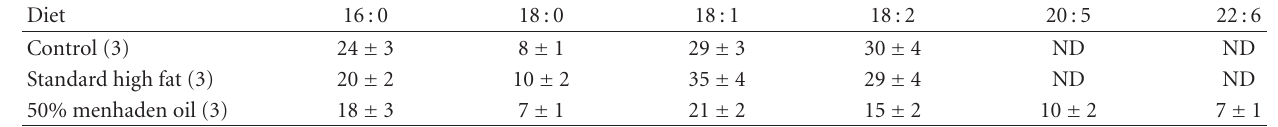
Table 1: Fatty acid % composition of diets measured by gas chromatography.